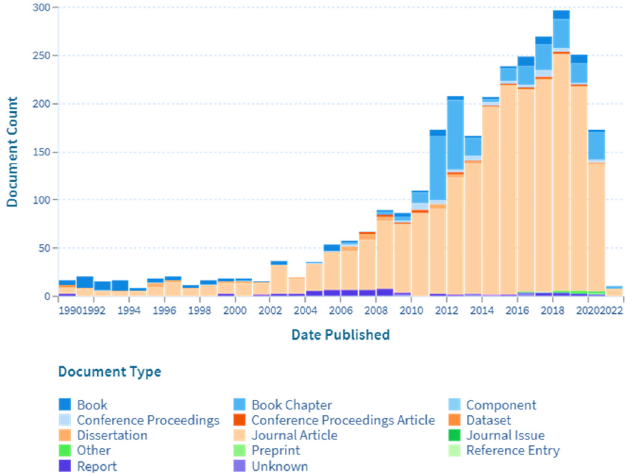
Figure 2. Scholarly work of surface acoustic waves on cellular biology from 1990 based on lens.org [18].